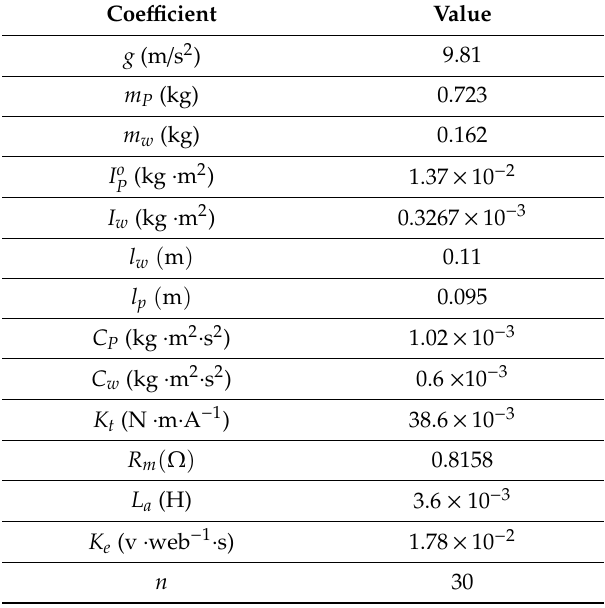
Figure 7. The server motor of the braking system. The whole braking system is shown in Figure 8, with arrow A representing the direction of where the servo motor pushes and arrow B expressing the brake pad’s direction moving from another side. After the servo motor triggers the braking system, the brake pad attached to the gadget will collide with the reaction wheel. Thus, the design can stop the reaction wheel efficiently. Figure 8. The braking system. 2.3. Signal Processing Units Figure 9 shows the signal processing units of the cube robot. The STM32F407 evaluation board (which mounted a Cortex-M3 clocked at 72MHZ) is the primary system processing unit. The IMU sensor consists of a 3-axis accelerometer, ADXL345 made from Analog Devices, and a 3-axis gyro made from InvenSense. The IMU sensor that mounts on the cube robot’s backside is connected to the STM 32F407 board. And the serial communication between them is Inter-Integrated Circuit ( I (cid:2870) C ).